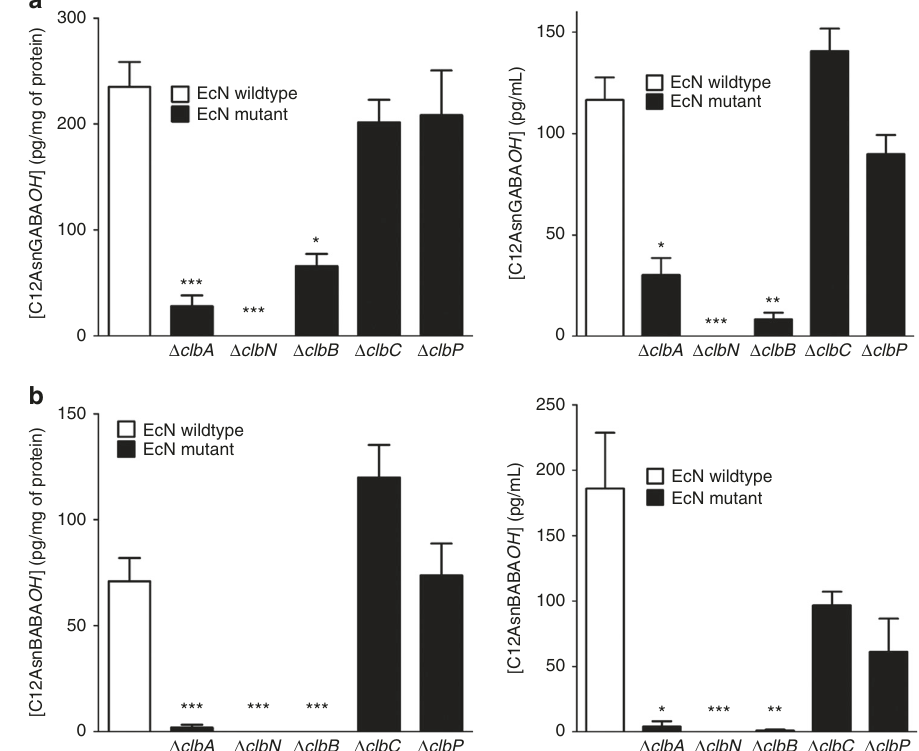
Fig. 4 Quanti fi cation of C12-Asparagine-aminobutyric acid by LC-QQQ. a Quanti fi cation of C12AsnGABA OH in pellets (left panel) and supernatants (right panel) of wild-type and mutated EcN. b Quanti fi cation of C12AsnBABA OH in pellets (left panel) and supernatants (right panel) of wild-type and mutated bacteria. Data are represented as mean ± SEM of two experiments of six independent bacterial cultures per group. Statistical analysis was performed using Kruskal – Wallis analysis of variance and subsequent Dunn ’ s post hoc test. * p < 0.05, ** p < 0.01, *** p < 0.001, signi fi cantly different from isotopic pattern corresponding to the anion formula − (Fig. 3b). Fragmentations displayed by [(C 20 H 37 N 3 O 5 )-H]